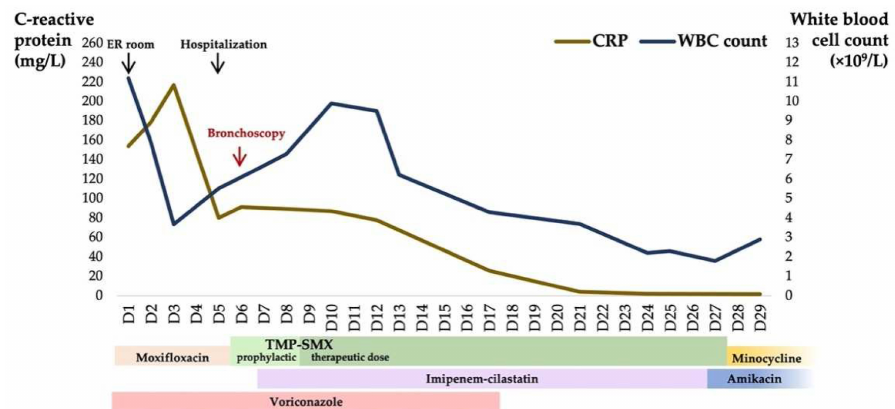
Figure 2. Changes in white blood cell count, C-reactive protein level and antimicrobial regimen during hospitalization. Arrows mark several important events.